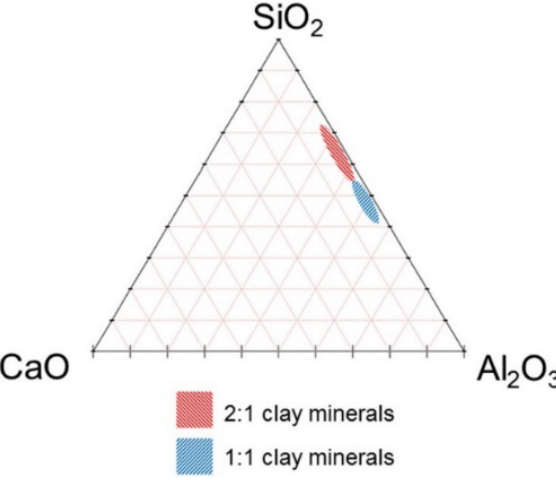
Figure 1: Compositional diagram showing the approximate composition range of clay